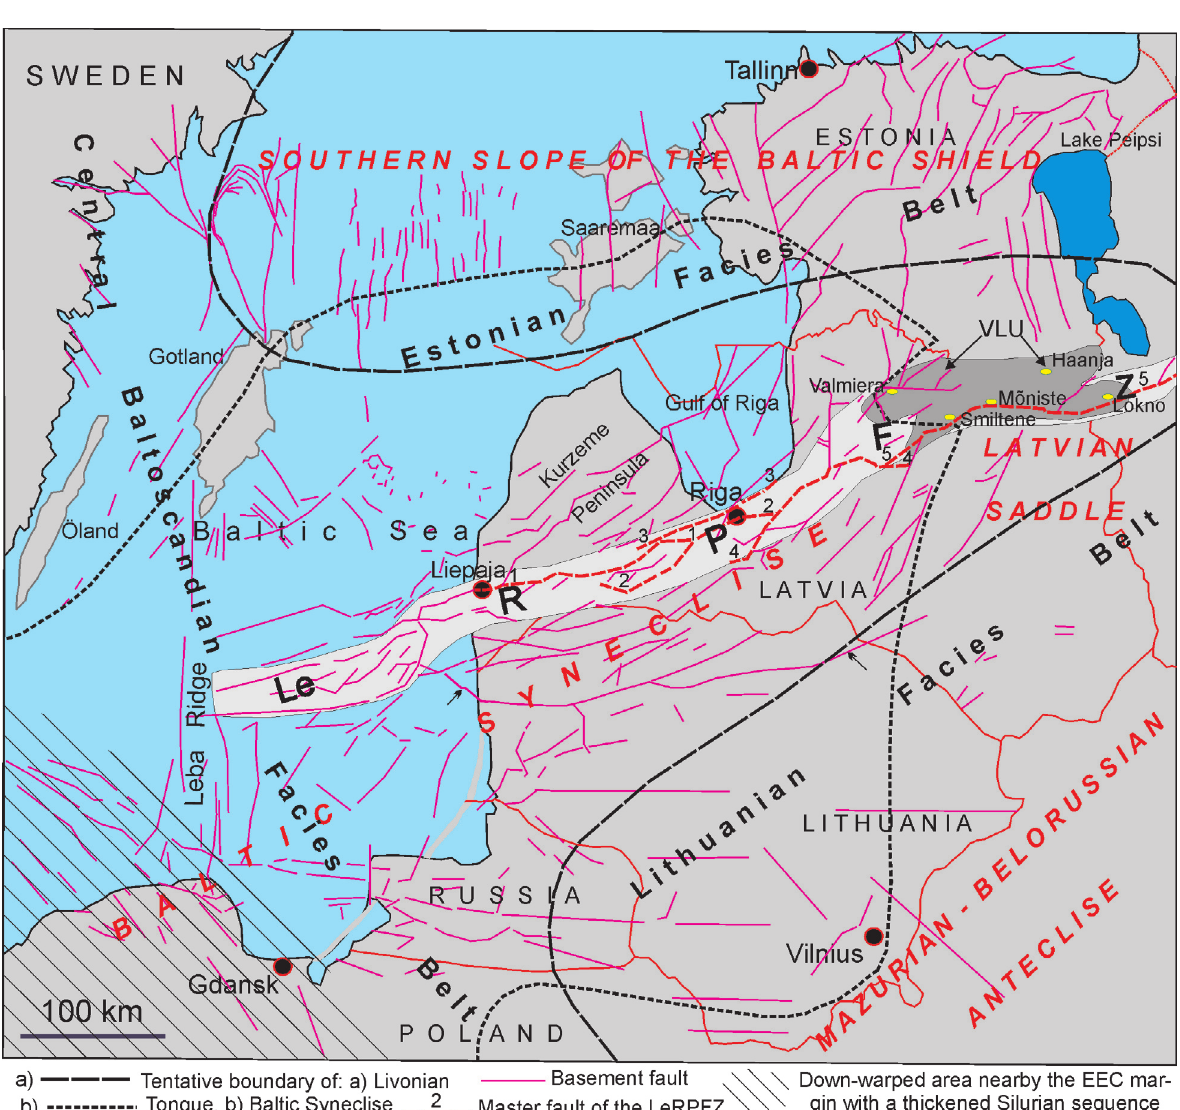
Fig. 1. Northwestern East European Craton with basement faults reflected in the overlying platform cover, major cratonic structures (red text), and facies zones with the northeasterly extending Livonian Tongue of the Baltic Ordovician Basin (modified after Kaljo et al. 2007). Numbered master faults of the Leba Ridge–Riga–Pskov Fault Zone (LeRPFZ): 1, Liepaja–Saldus; 2, Dobele–Babite; 3, Olaine–Inčukalna; 4, Sloka–Carnikava; 5, Smiltene–Ape. VLU, Valmiera–Lokno Uplift with basement cored anticlines (yellow